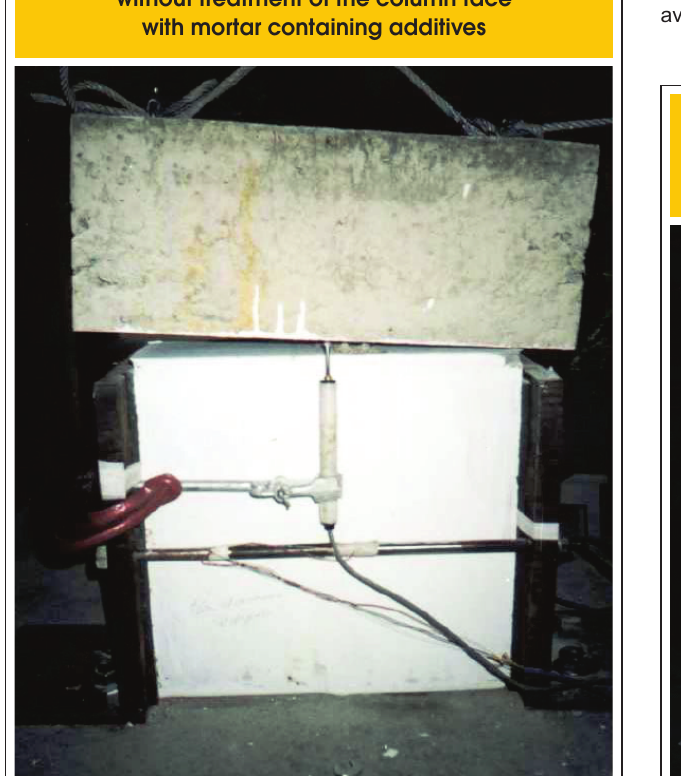
Figure 12 – Photo of typical rupture in the model without treatment of the column face with mortar containing additives